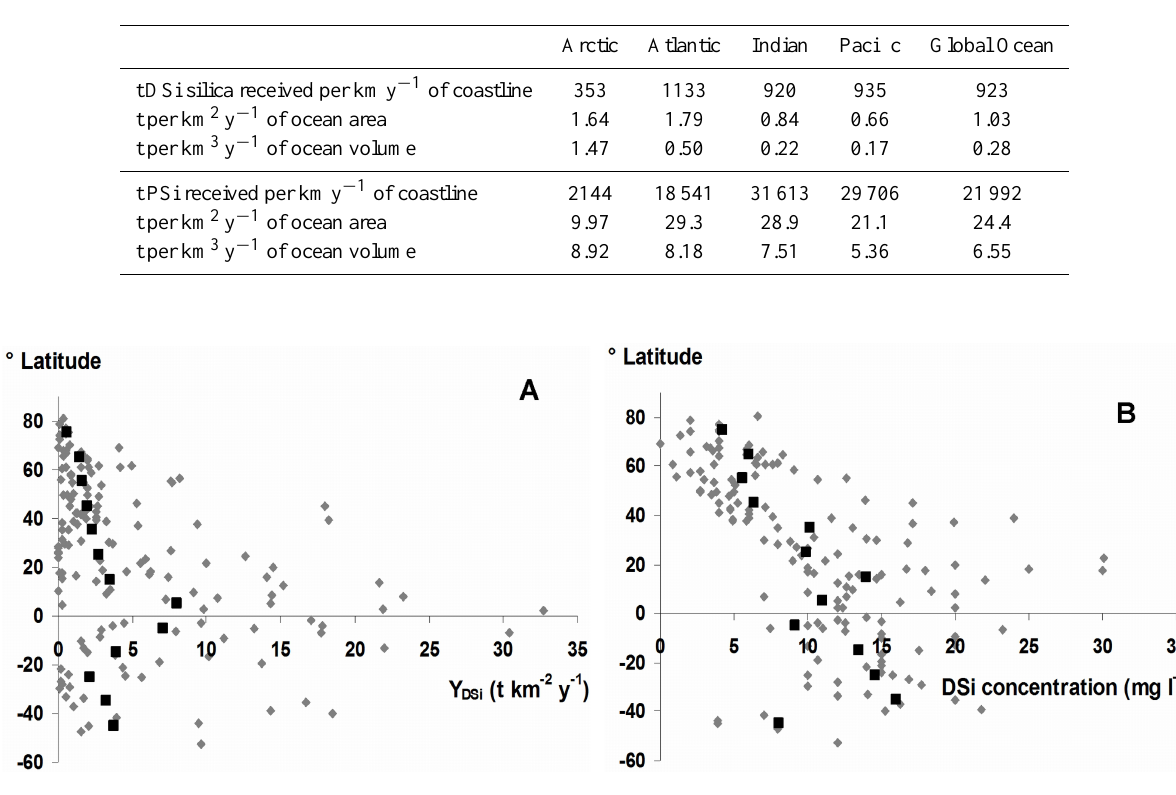
Table 3. Dissolved and particulate silica fluxes received by coastal zones related to ocean basins, rated to coastline length, ocean areas and ocean volumes. Retention of silica in estuaries, on shelves and in regional seas is not considered here. Coastline length, ocean area and ocean volume according to Meybeck et al. (2006, 2007).